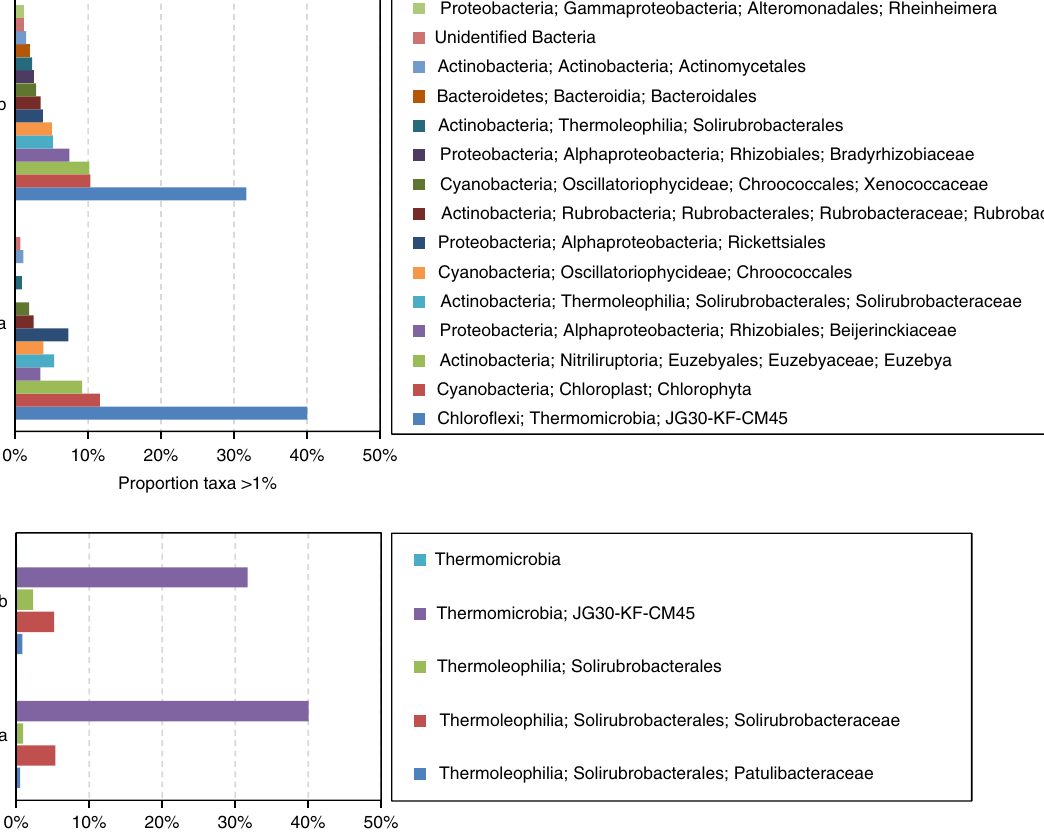
Figure 3 | Microbial associations from two sparite samples. ( a ) Bacterial taxa present at 4 1% of the total diversity graphed along with the lowest taxonomic identification possible. ( b ) Thermophilic bacteria close to known taxa. The proportion of Thermomicrobia (blue) and Thermoleophilia (green) taxa of the total species determined is